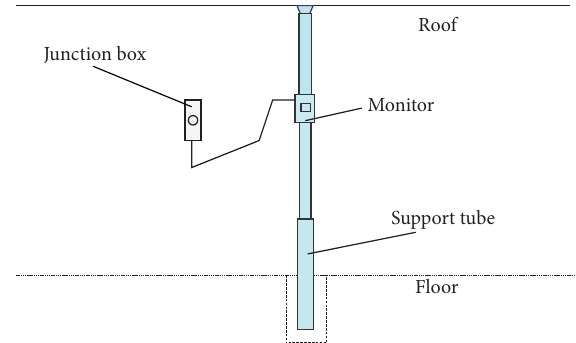
Figure 11: Supporting structure of top and bottom plate sinking position state instrument.